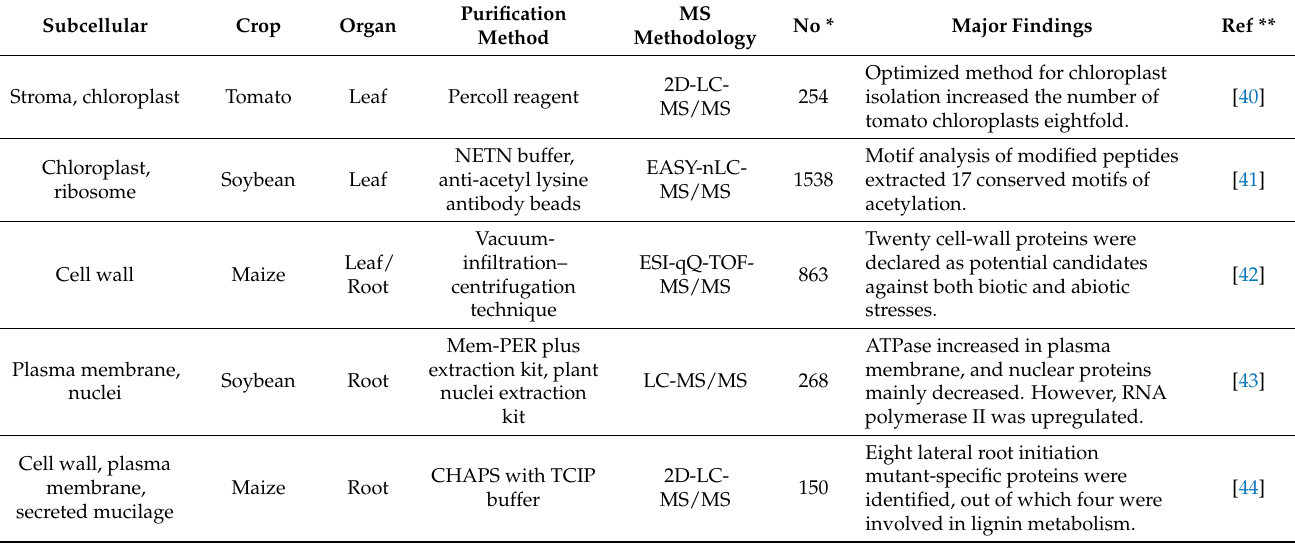
Table 2. Subcellular proteomics employed in crop research during